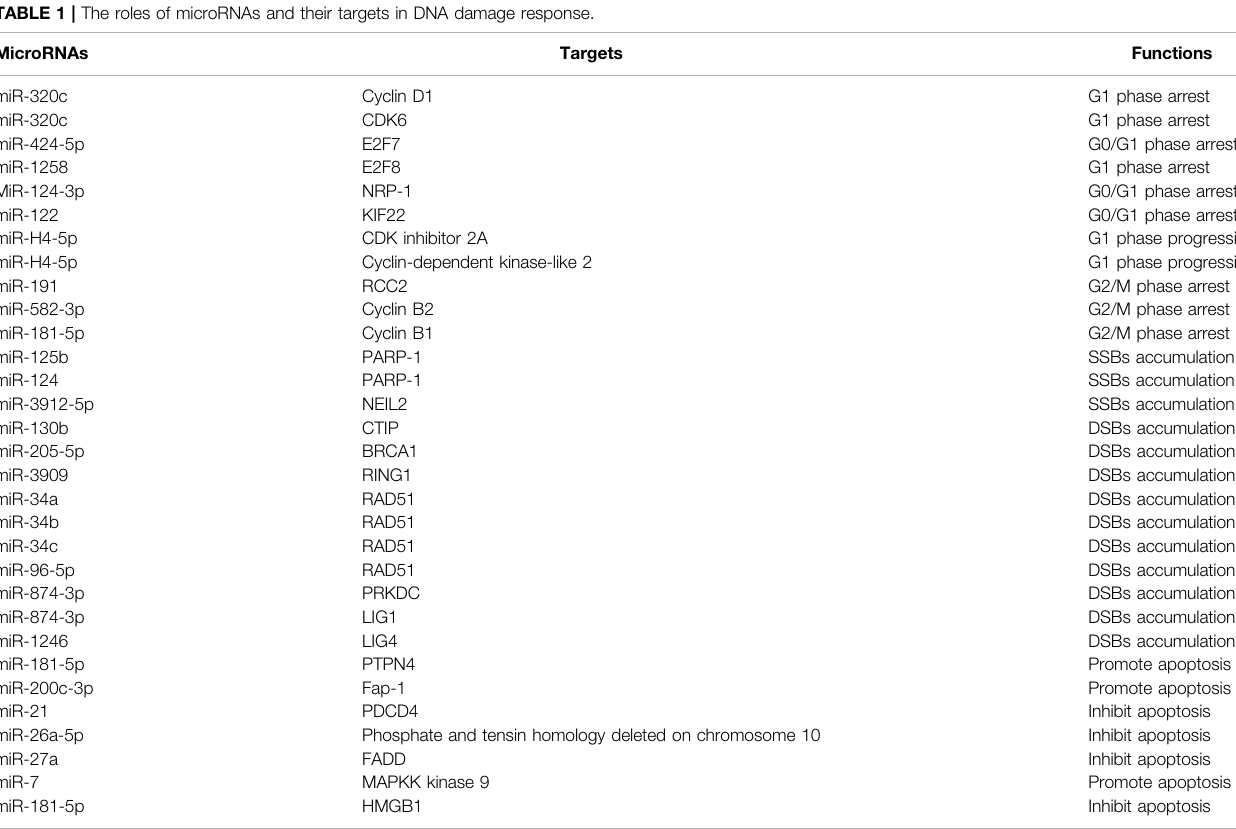
TABLE 1 | The roles of microRNAs and their targets in DNA damage response. MicroRNAs Targets Functions